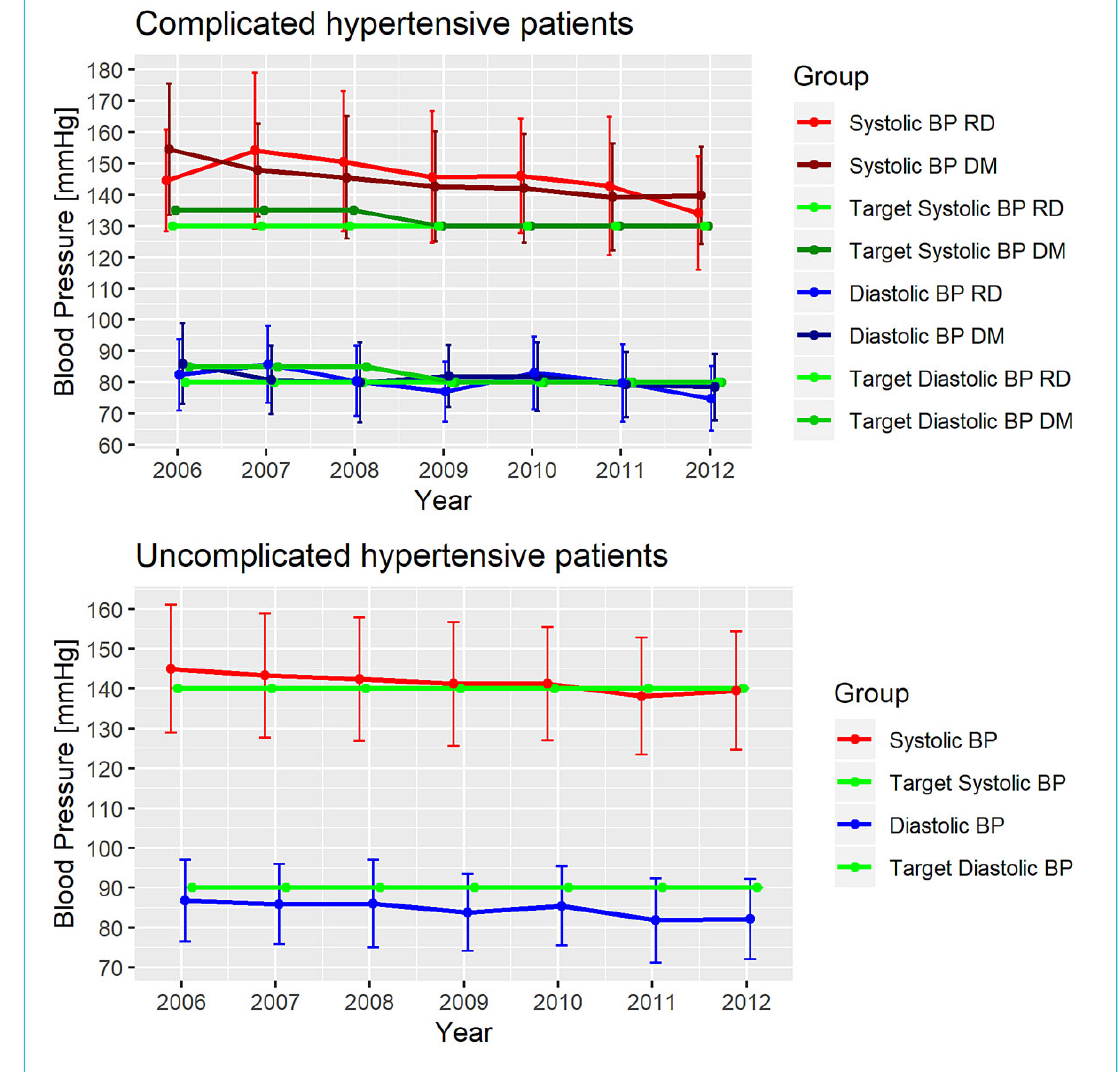
Figure 1: Change in mean blood pressure over time in patients with complicated hypertension and patients with uncomplicated